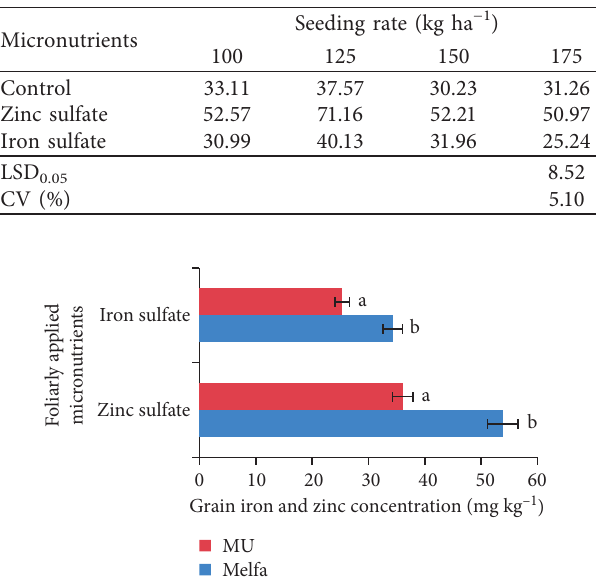
Table 1: Interaction effect of seeding rate and applied micro- nutrients on grain zinc and iron concentrations (mg kg − 1 ).